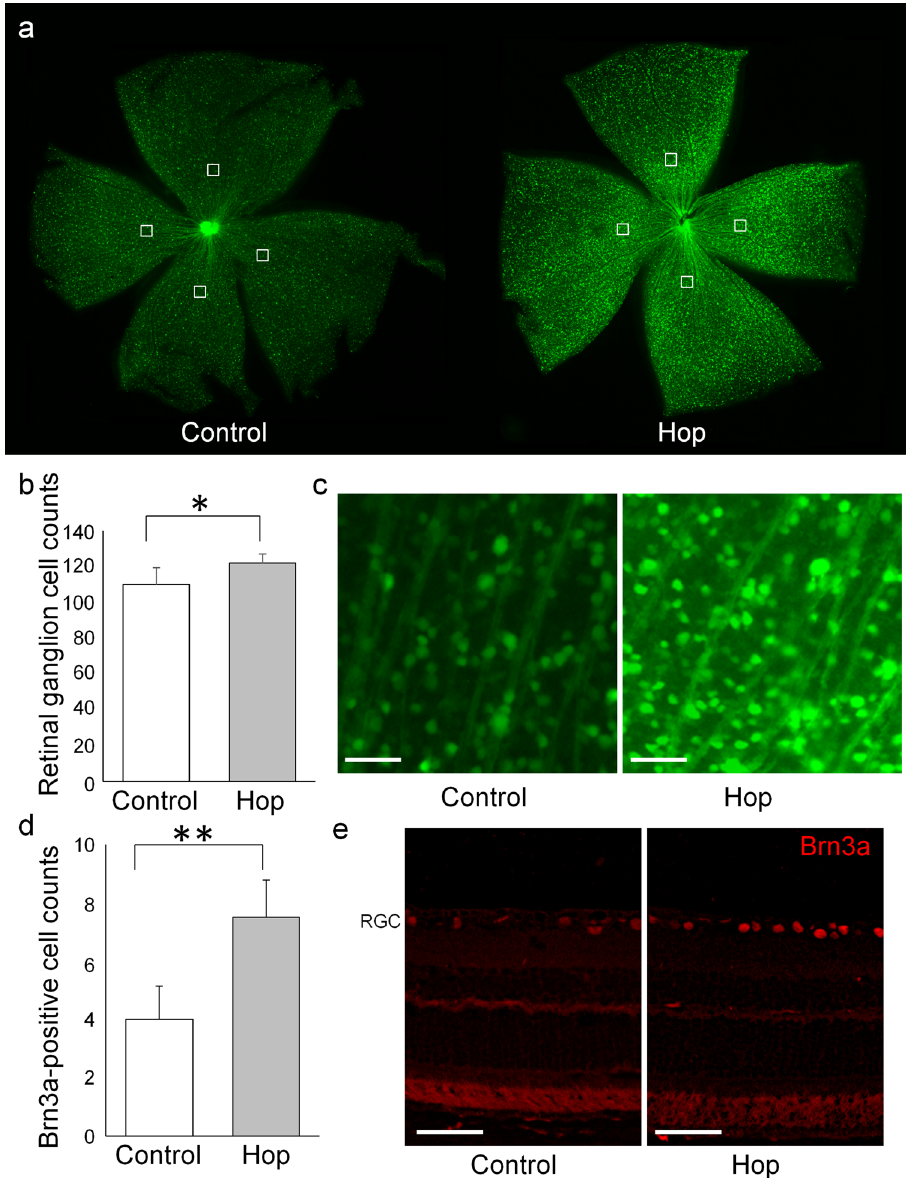
Figure 3. Prevention of retinal ganglion cell decrease in GLAST (+/−) mice administered with hop extracts on retinal flatmounts and immunohistochemical evaluation. ( a – c ) Retinal flatmounts of 12-month-old GLAST (+/−):Thy1-CFP mice administered hop extracts or water as a control. CFP positive retinal ganglion cells were manually counted in a masked fashion within 250 μm squares (white squares in a ), at a distance of 1200 μm from the disc center, in four directions. ( b ) Ganglion cell counts of 12-month-old GLAST (+/−):Thy1-CFP mice administered with hop extracts or water as a control. *p ≤ 0.05, unpaired t -test, n = 6 eyes, respectively. ( c ) Representative images of counted squares of hop-treated or control 12-month-old GLAST (+/−):Thy1- CFP mice. ( d , e ) Immunohistochemical analysis using anti-brain-specific homeobox/POU domain protein 3A (Brn3a) antibody in hop-treated or control 12-month-old GLAST (+/−) mice retinas. ( d ) Brn3a-positive retinal ganglion cells in the retinal ganglion cell layer (RGC) were counted in a masked fashion within a distance between 1000 and 1100 μm from the disc center. **p ≤ 0.01, unpaired t -test, n = 4 eyes, respectively. ( e ) Representative images of sections immunostained with anti-Brn3a antibody. Bars represent 50 µm in ( c ) and ( e